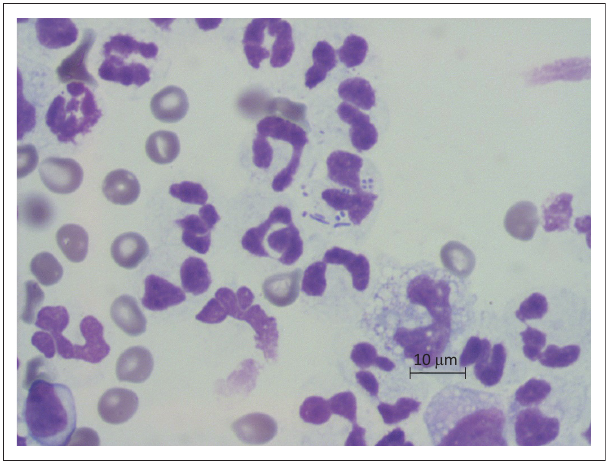
FIGURE 2: Light microphotographs of the pericardial effusion smears. There is a predominance of degenerate neutrophils with phagocytosing rods and cocci. Three species of bacteria were isolated from the pericardial fluid.